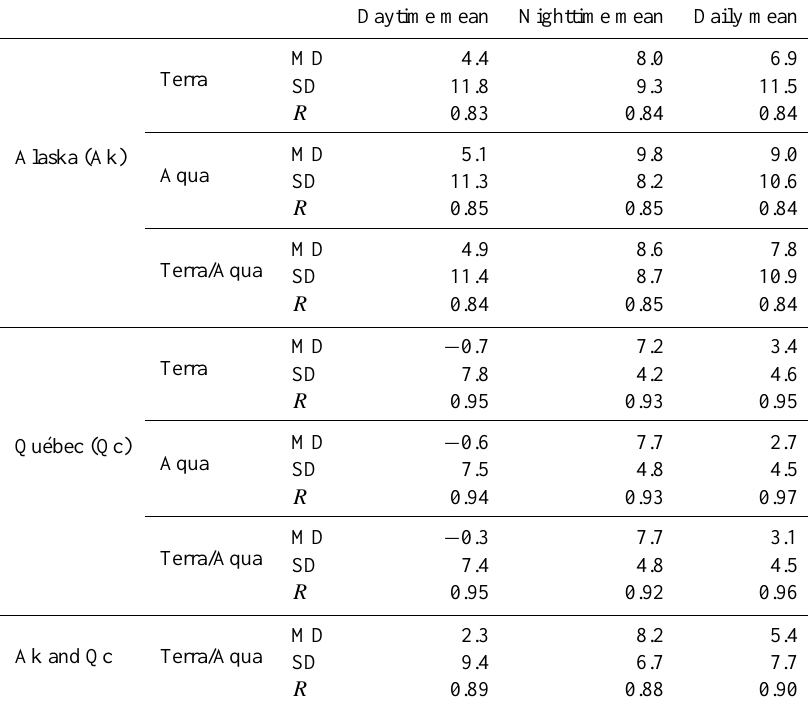
Table 5. Mean Difference (MD), Standard Deviation (SD) and Correlation ( R ) between GST and LST for daytime, nighttime and daily average from Aqua and Terra separately, and Aqua/Terra combined.